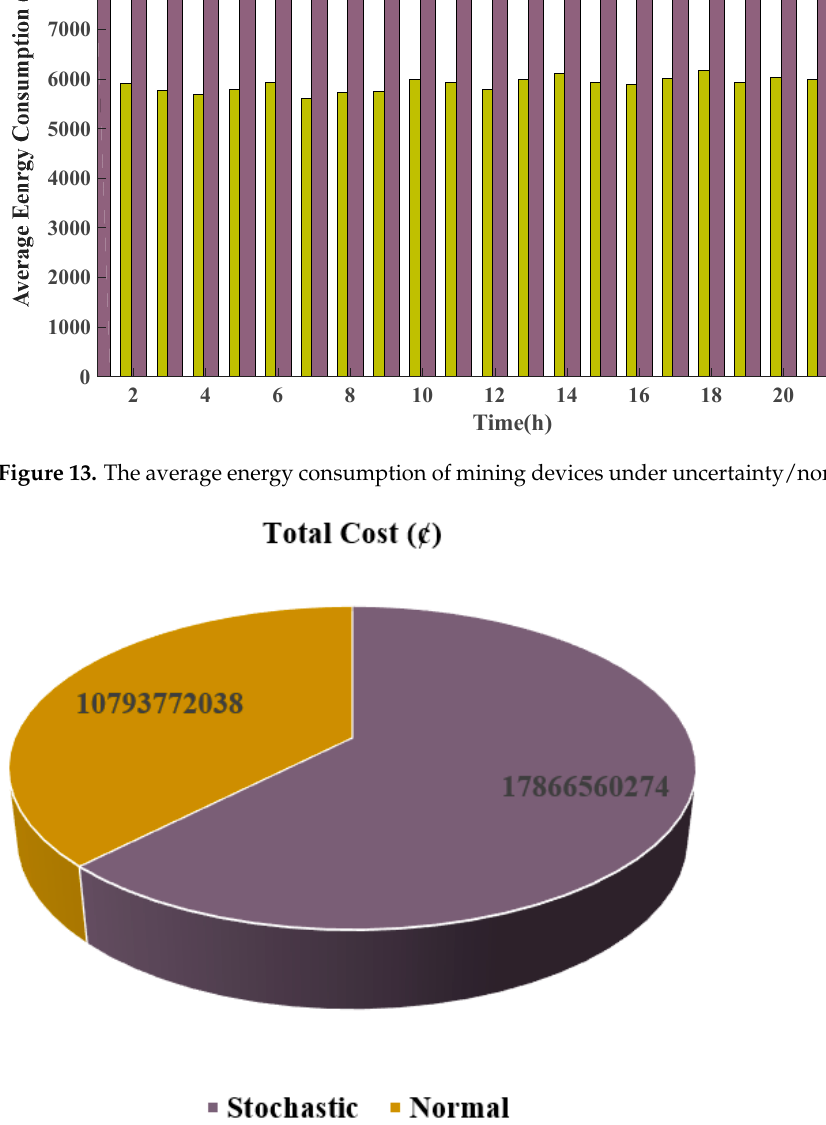
Figure 14. The total cost under uncertainty/normal conditions.